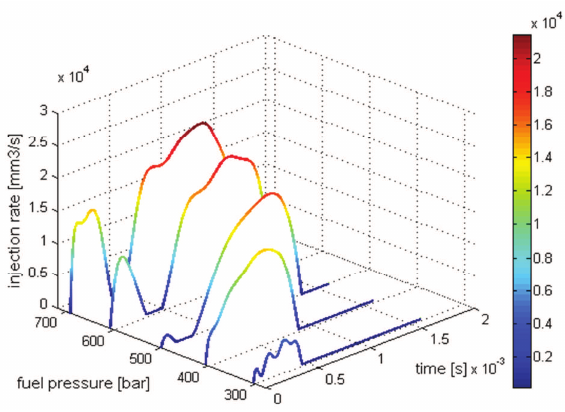
Fig. 1. Injection courses of two-portion dose (first measuring group)